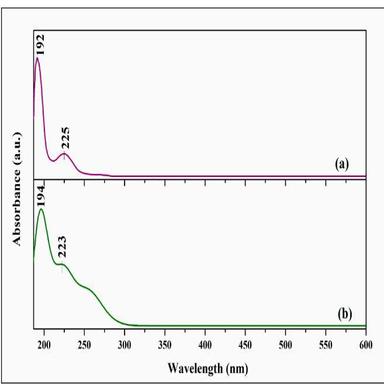
UV–Visible spectra of GuHM (a) Experimental (b) Theoretical.